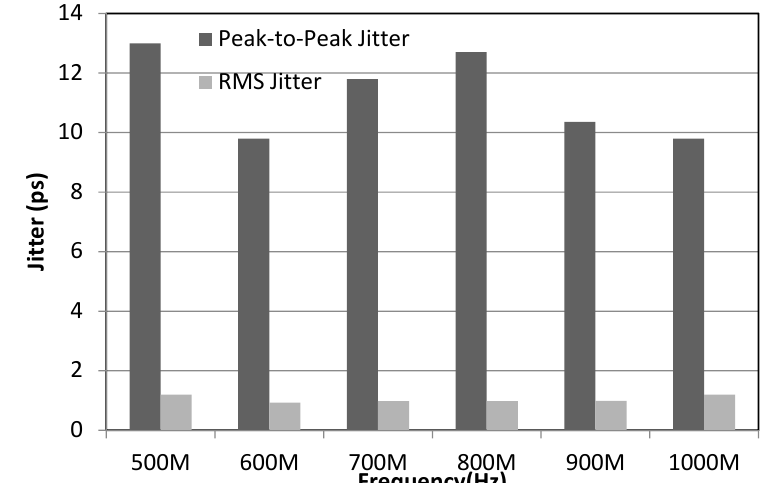
Figure 12. Phase error with different input frequency.